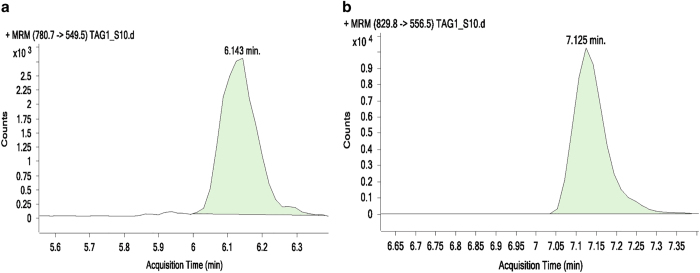
Extracted ion chromatograms (EIC) for individual TAG MRM transitions, displayed in the Agilent QQQ quantitative analysis software.(a) EIC for 45:1–13:0-TAG and (b) EIC for 48:0-16:0-TAG. Varying retention times can be observed with 45:1–13:0-TAG elution starting at 6:00 min while that of 48:0-16:0-TAG at 7:00 min due to the difference in hydrophobicity.